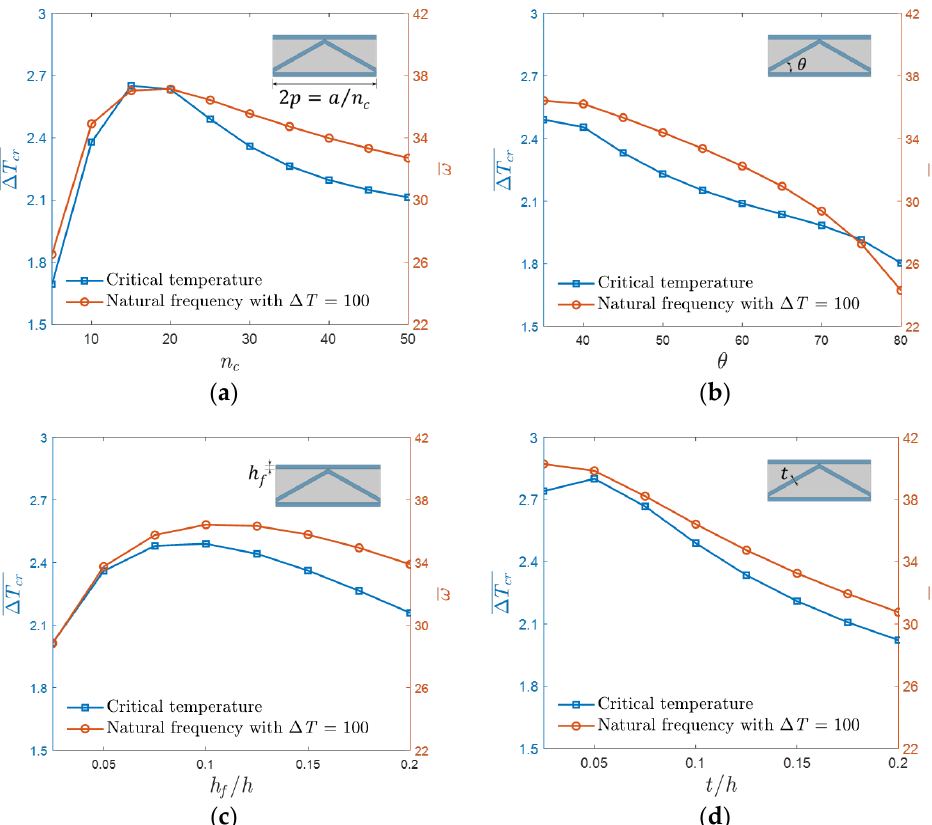
Figure 8. Effects of geometric parameters of ( a ) number of unit cell; ( b ) inclined angle; ( c ) facesheet thickness; ( d ) corrugation thickness on critical temperature change and dimensionless fundamental frequency with temperature change Δ T = 100.